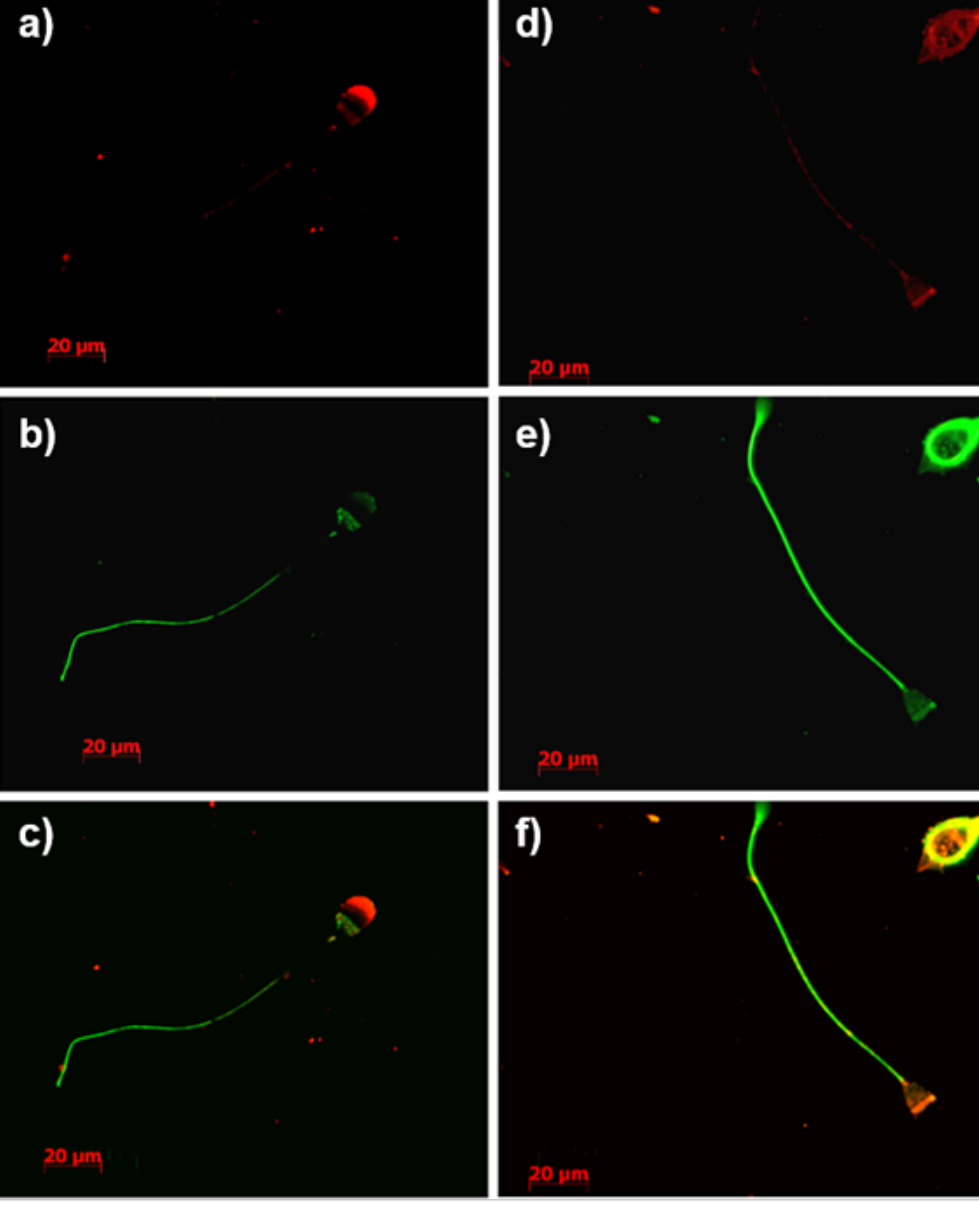
Figure 3. Immunolocalization of tACE ( a , d ; red), β -tubulin ( b , e ; green), with overlaid merges of red and green channels ( c , f ) in fresh (0 h control) ( a – c ) and capacitated ( d – f ) bovine sperm. Images were captured using an inverted phase contrast fluorescence microscope (Zeiss Axio Observer Z1) equipped with Axiocam MRc5 using a 100× oil-immersion objective lens. Co-localization of beta- tubulin and tACE within the sperm tail was demonstrated in Figure S1 as this was not clear in Figure 3.